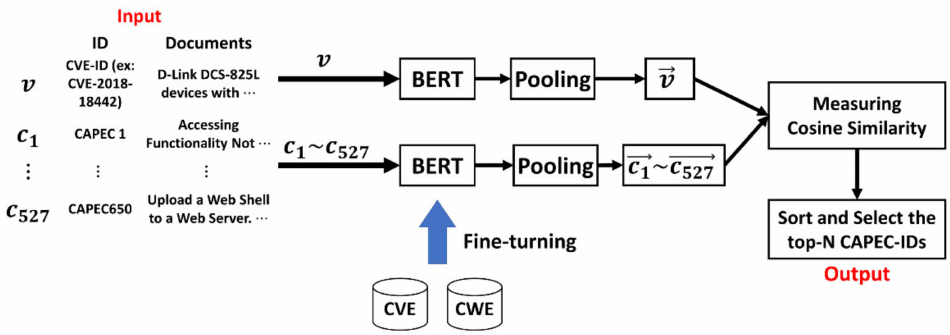
Figure 4. Overview of the tracing method based on